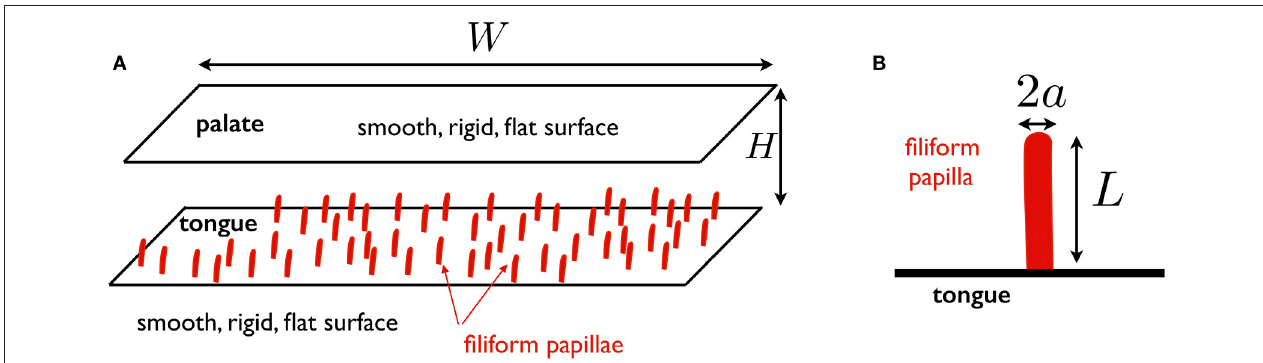
FIGURE 1 | (A) Schematic representation of mouth model used in this work. The palate and the tongue are assumed to be smooth, rigid, flat surfaces. The tongue is located at a distance H from the palate and the total width of the fluid region in the anterior-posterior direction is denoted W ; (B) Schematic representation of papilla model: a straight elastic rod of length L , radius a , clamped on the